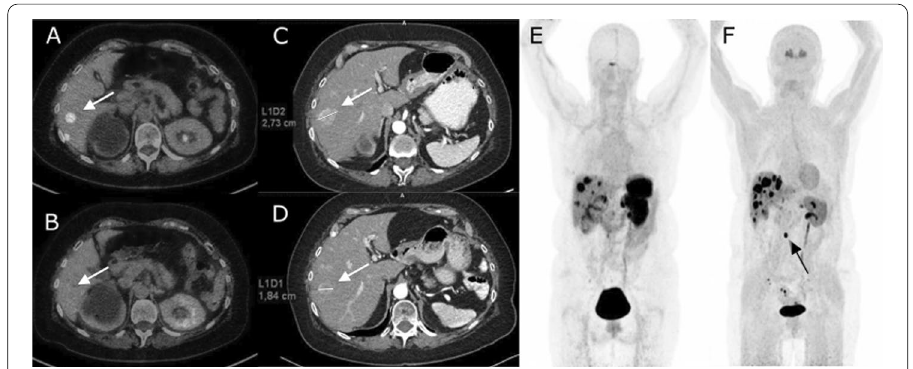
Fig. 1 Imaging of a 70-year-old female patient (#2) with a metastasized primary colon NEN (G2). Fourteen tumours were found, of which 11 only by [18F]DOPA PET/CT and three by both PET tracers. PET/CT shows tumour uptake of [18F]DOPA in the liver ( A ), while [68 Ga]DOTA-TOC shows none ( B ). The same tumour had a longest axis diameter of 27 mm on the pre-PRRT CT scan ( C ), reduced to 18 mm in the post-PRRT CT scan ( D ). These images display significant therapy effect of PRRT in a tumour only found by [18F]DOPA. Maximum intensity projection (MIP) images show higher incidence of focal uptake of [18F]DOPA ( F ) in the liver compared to [68 Ga]DOTA-TOC ( E ). A positive para-aortal lymph node was found only by [18F]DOPA (F, black